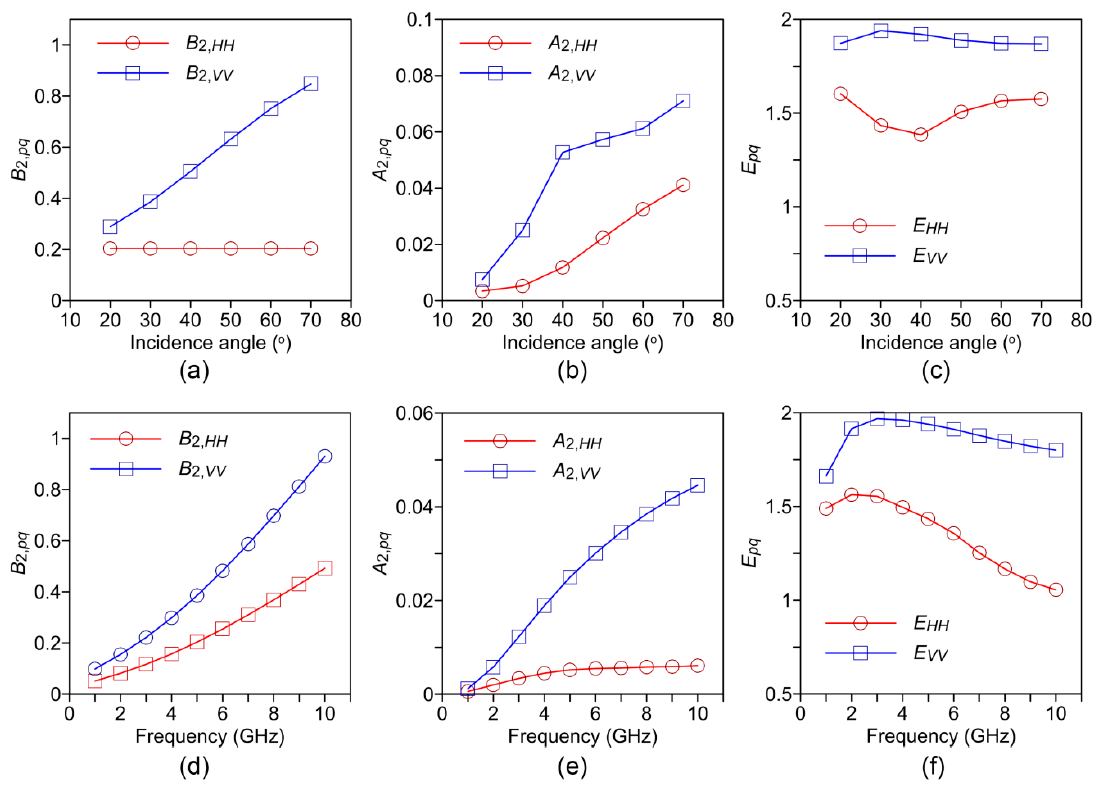
Figure 8. The estimated WCM parameters B 2, pq (left), A 2, pq (middle), and E pq (right) plotted as a function of ( a – c ) the incidence angle and ( d – f ) the radar frequency.